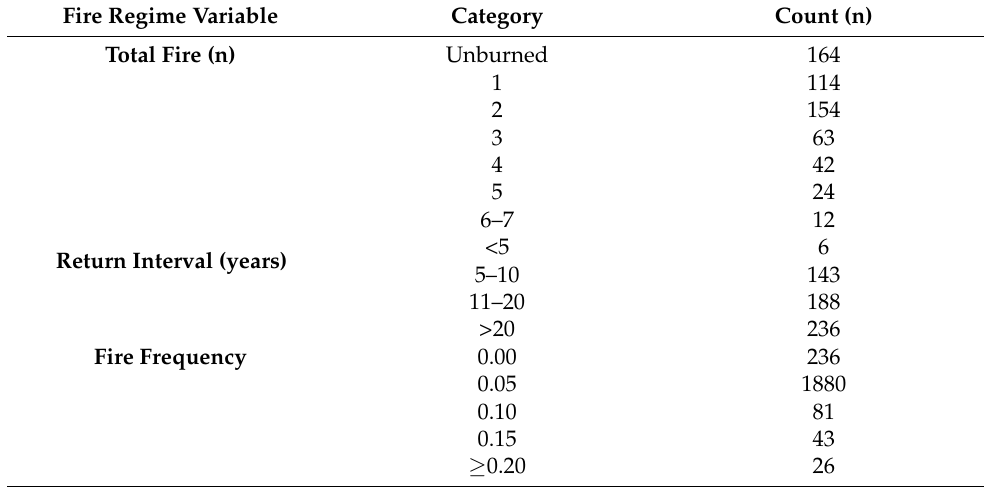
Table 1. Summary statistics of the fire regime response variables. The total fire number was the sum of the fires between 1955 and 2015. The mean fire return interval and frequency were based on fire data between 1995 and 2015. Sites that did not burn between 1995 and 2015 were designated as a fire return interval of more than 25 years and had a fire frequency of